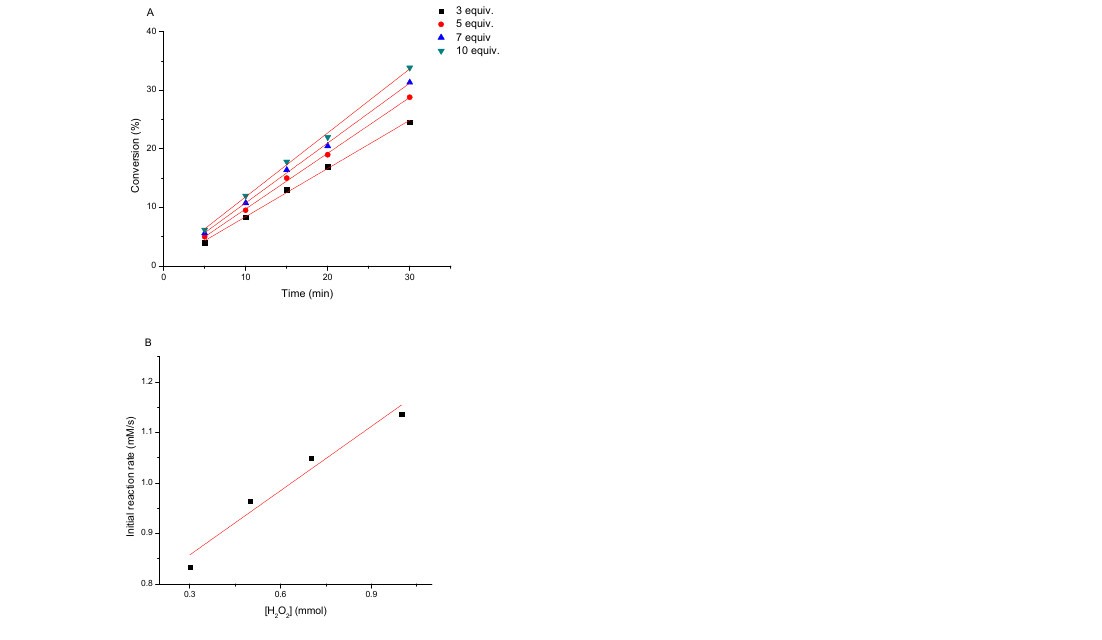
Figure 6. Influence of H 2 O 2 concentration on ( A ) styrene conversion and ( B ) initial reaction rate of styrene oxidation. Reaction conditions: T = 80 ℃ ; [styrene] = 0.2 mmol; [catalyst] = 0.002 mmol; acetonitrile = 3 mL.